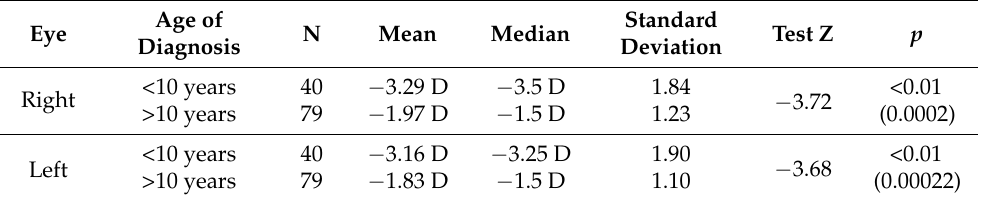
Table 4. Spherical refractive error in myopic students depending on their age of diagnosis.